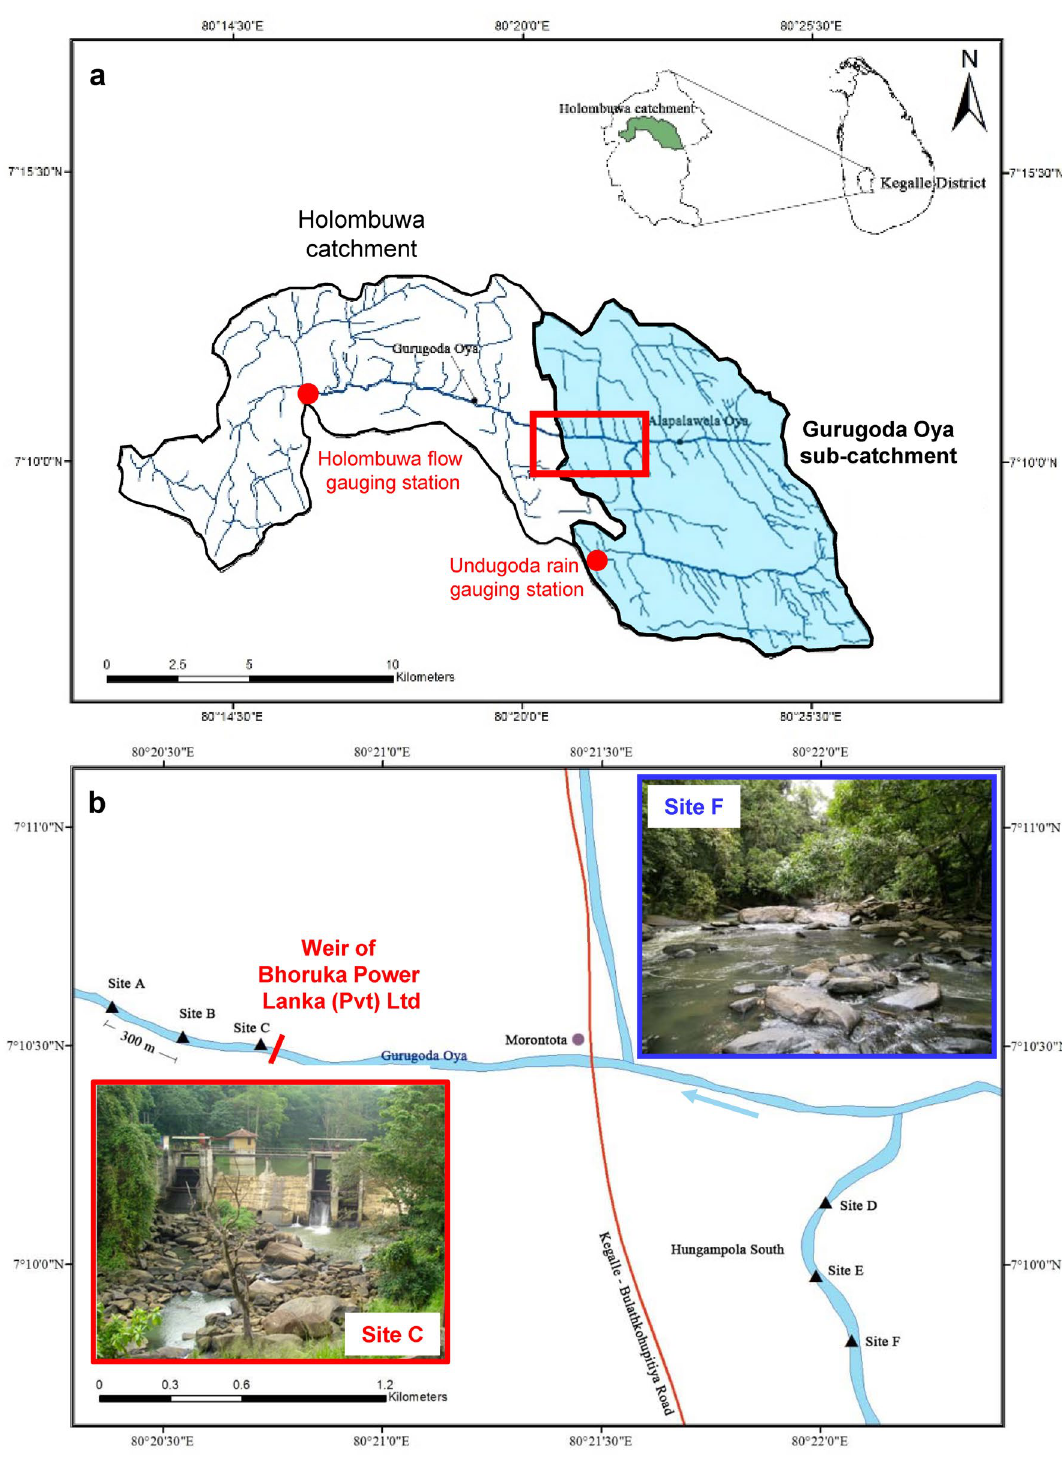
Figure 5. ( a ) Location of Kegalle District in Sri Lanka, and of Holombuwa Catchment in the Kegalle District. The flow and rain gauging station and the Gurugoda Oya sub-catchment (blue) within the Holombuwa catchment are also shown. The red rectangle includes the area where the weir and the sampling sites are located. ( b ) The blow-up shows the six sampling sites with respect to the weir of the mini-hydropower plant in the Gurugoda Oya sub-catchment. The maps were generated using ArcGIS software (version 10.0, https ://enter prise .arcgi